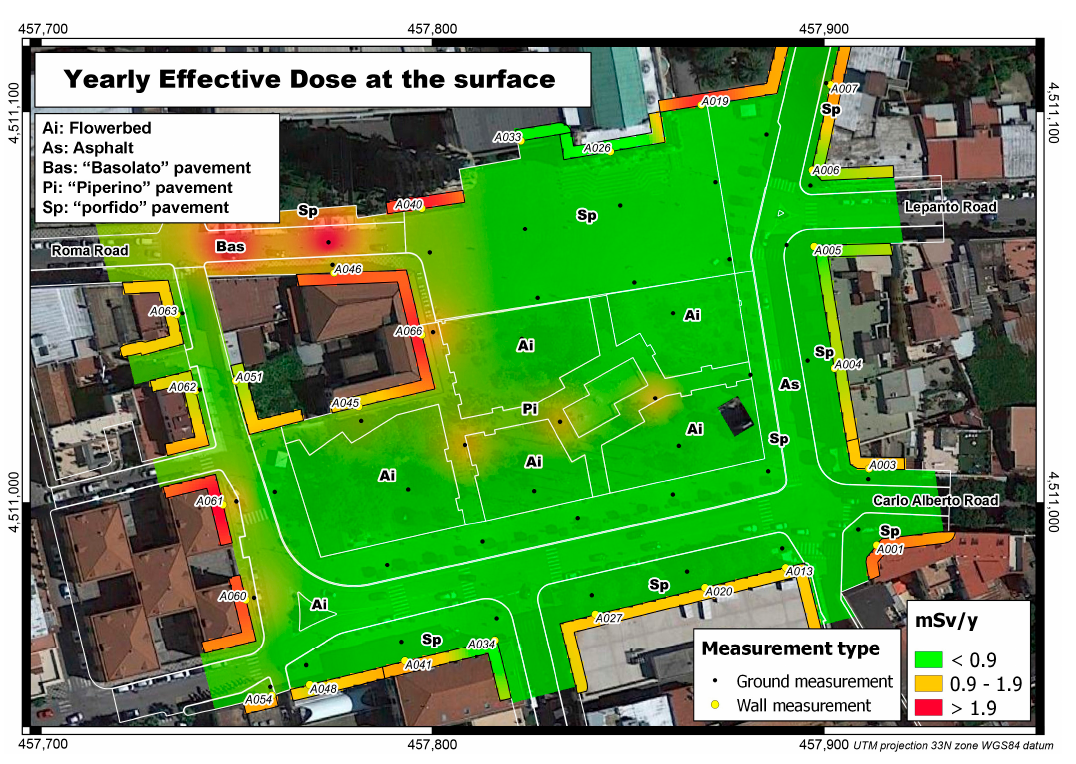
Figure 2. Pompei, Bartolo Longo Square. Map of the Yearly Effective Dose at the walkable surface, made by Inverse Distance Weighting interpolation method.